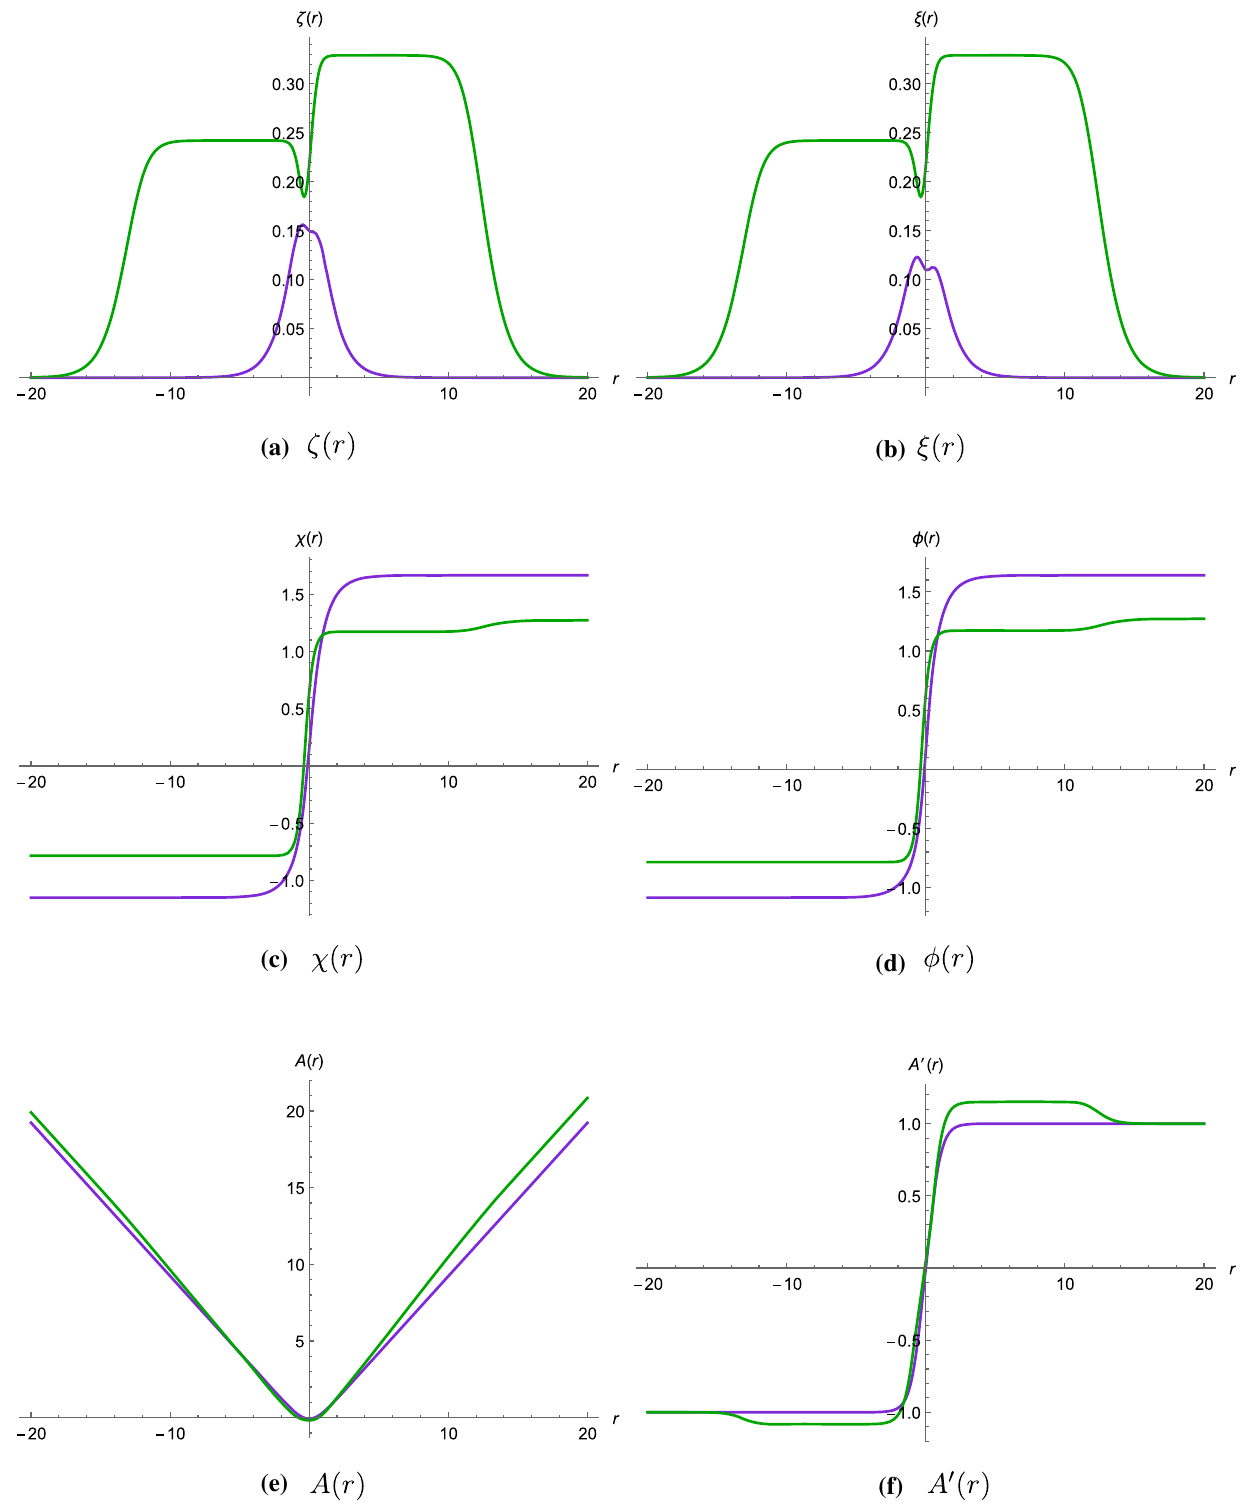
Fig. 11 Profiles of scalar fields (ζ,ξ,χ,φ) and the warped factor A for SO ( 8 )/ SO ( 8 ) and G 2 / G 2 Janus solutions with ω = π the radial coordinate